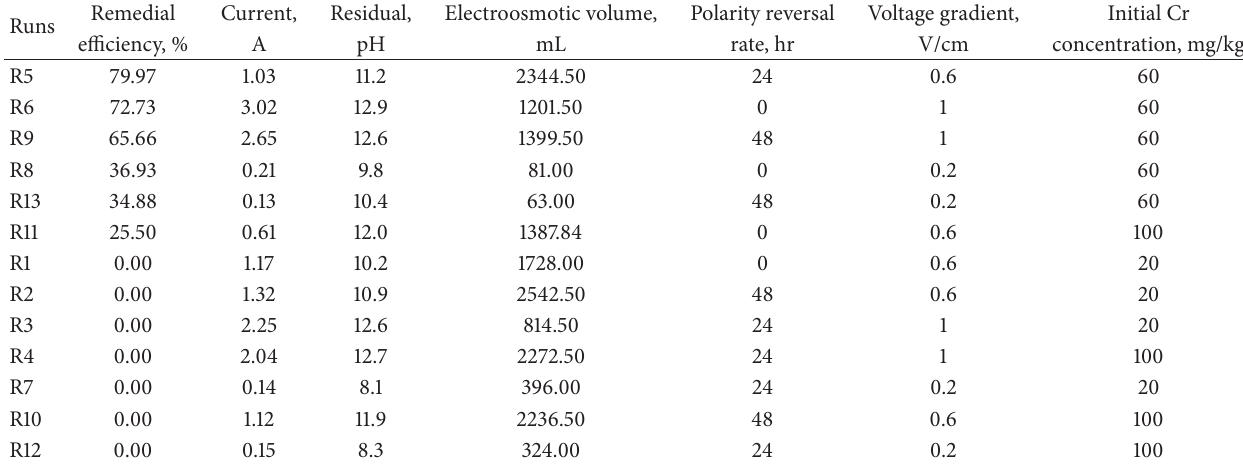
Table 7: Comparing trivalent Cr remedial efficiency with factors and some responses.